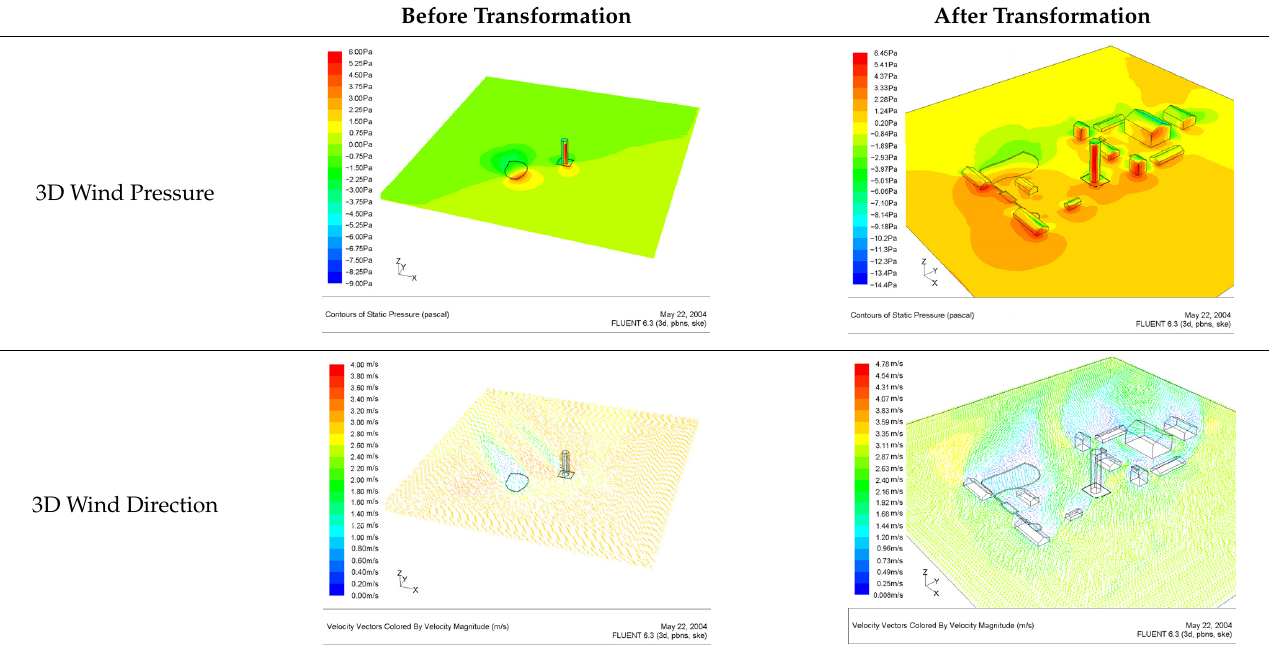
Table 3. Three-dimensional wind pressure and direction maps (the picture above shows the situation before the transformation). Before Transformation After Transformation